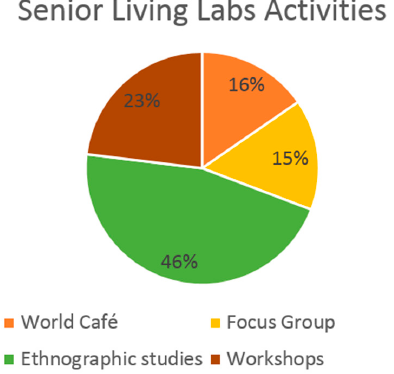
Figure 1. Activities of the SLL (Senior Living Lab) during the first year.